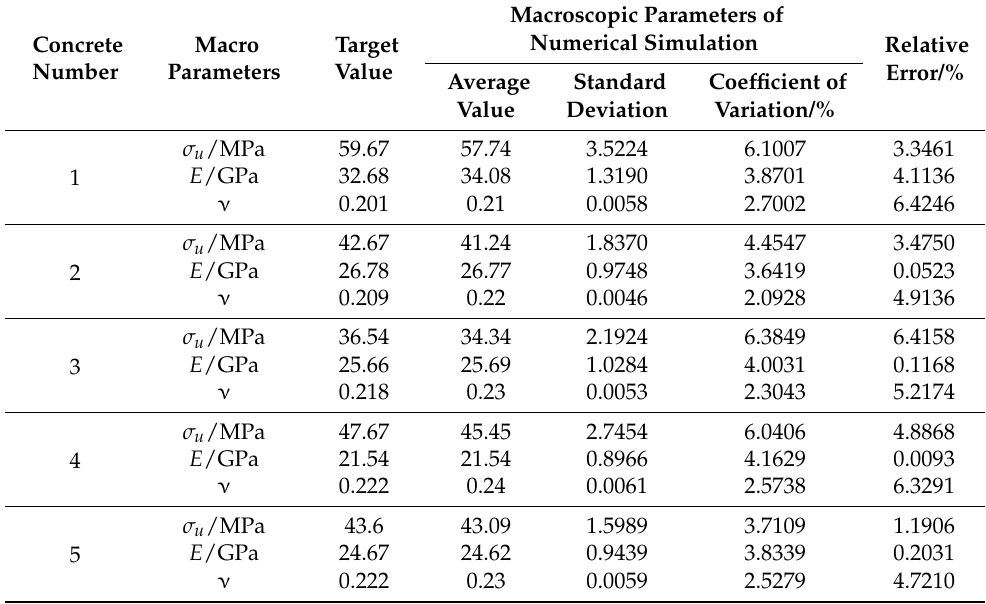
Table 15. Results and errors of macroscopic parameter